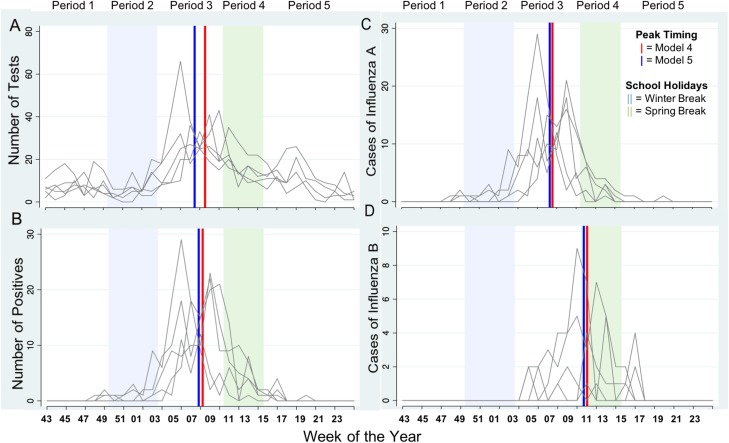
Weekly tests, positives, influenza A and B (panels A–D, respectively) for all ages across each study year with superimposed peak timing estimates in Milwaukee, WI (2004–2009). The five time periods include period 1 – before Winter Break (5 weeks), period 2 – during Winter Break (4–6 weeks), period 3 – between Winter and Spring Breaks (6–9 weeks), period 4 – during Spring Break (2–3 weeks) and period 5 – after Spring Break (5 weeks). All holiday breaks refer to the university school calendar.